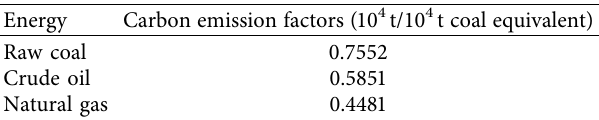
Table 2: Carbon Emission factors of fossil energy consumption in